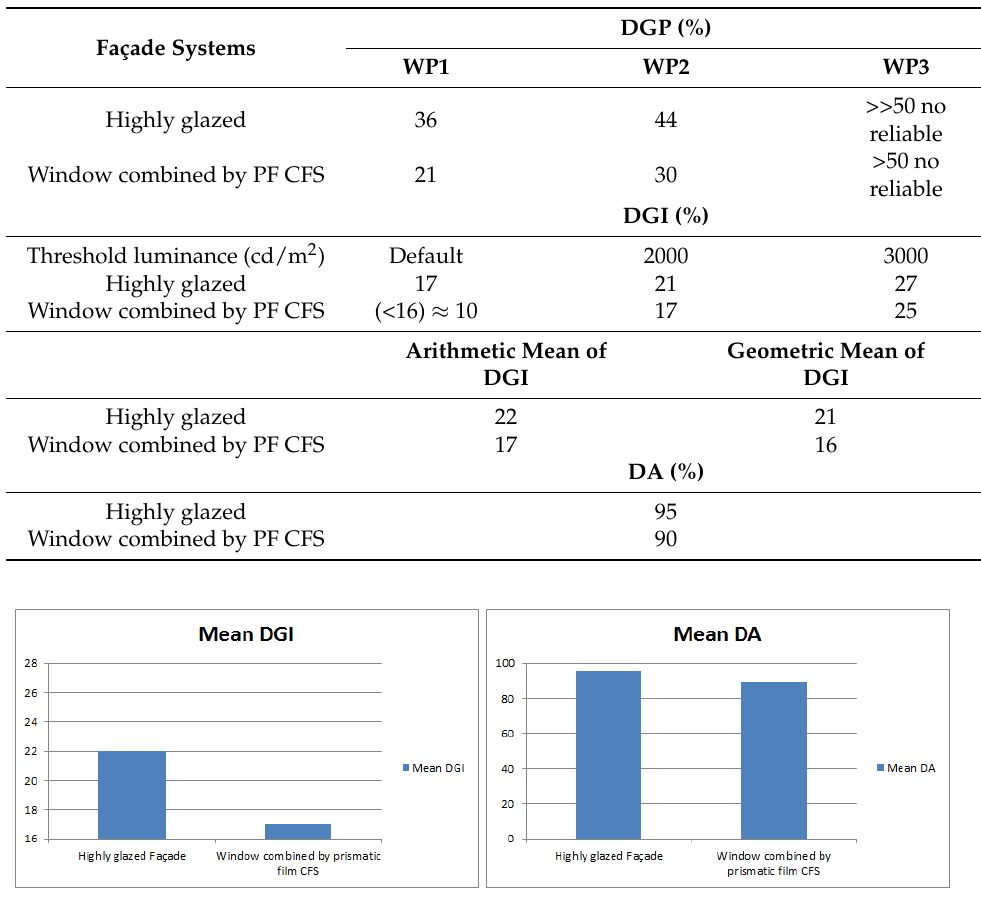
Figure 14 . Arithmetic mean Daylight Glare Index (DGI) and mean DA results for highly glazed façade system and window combined by prismatic film CFS façade system.